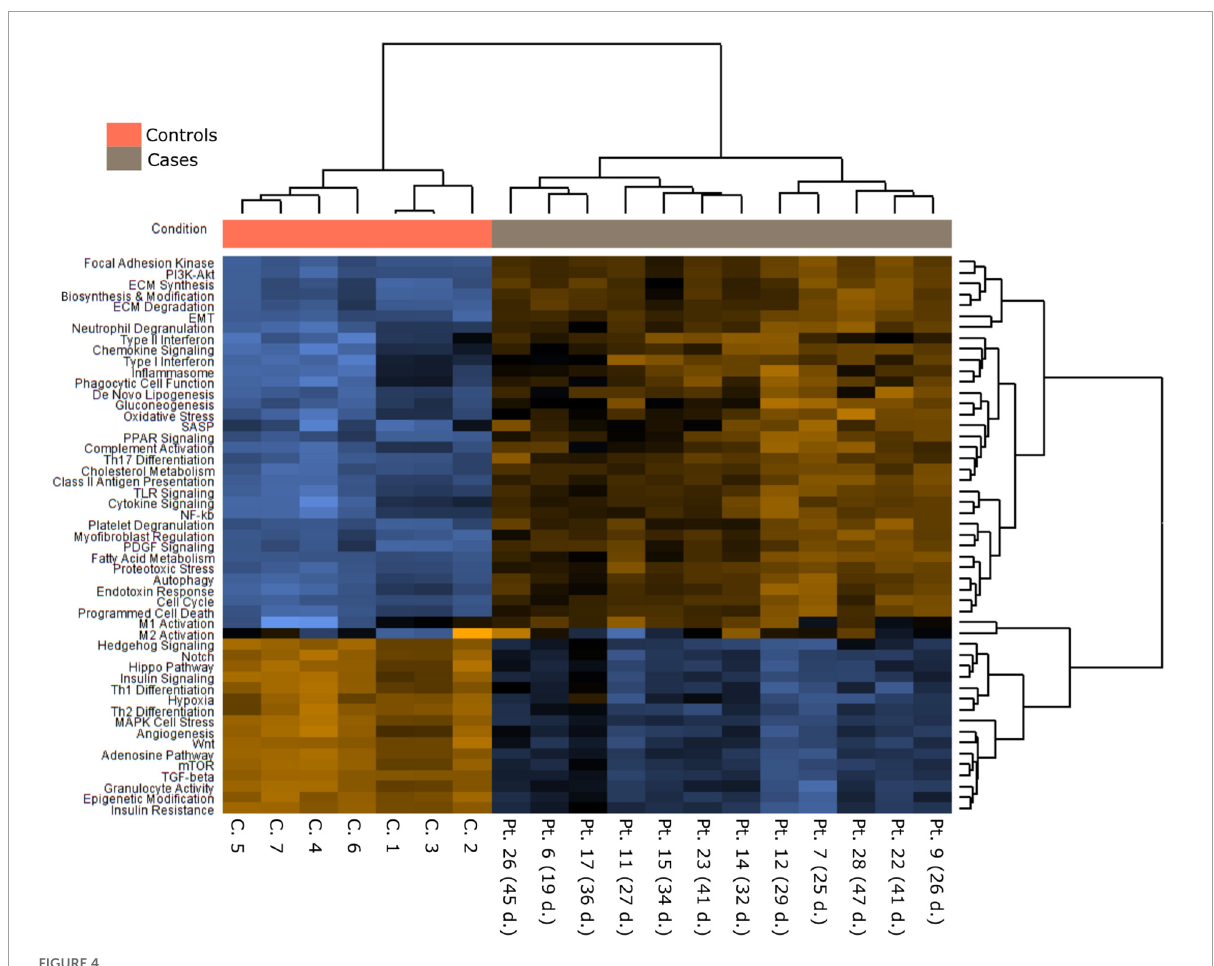
FIGURE4 A Pathways differently expressed in normal and COVID-19